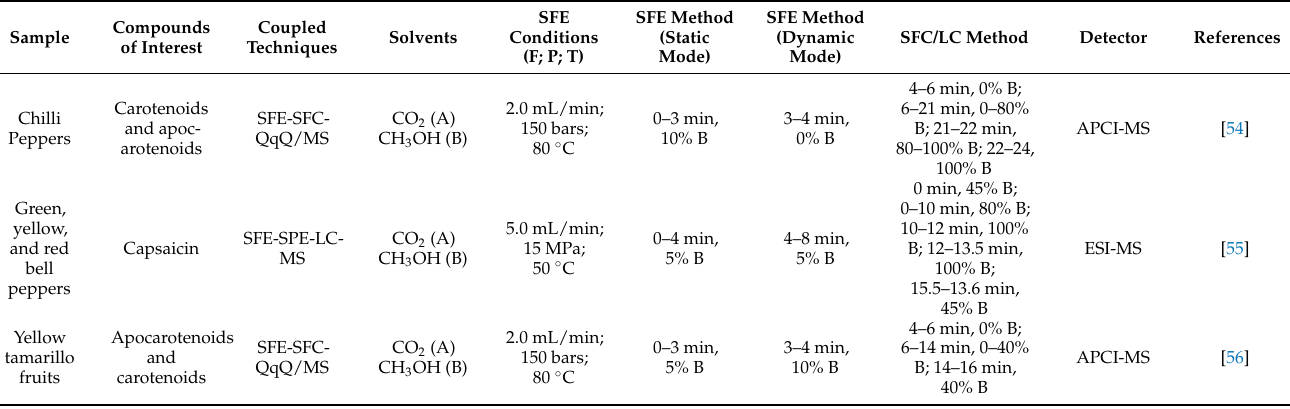
Table 4. Comprehensive report of SFE systems coupled with on-line analysis systems for solid matrices from vegetable